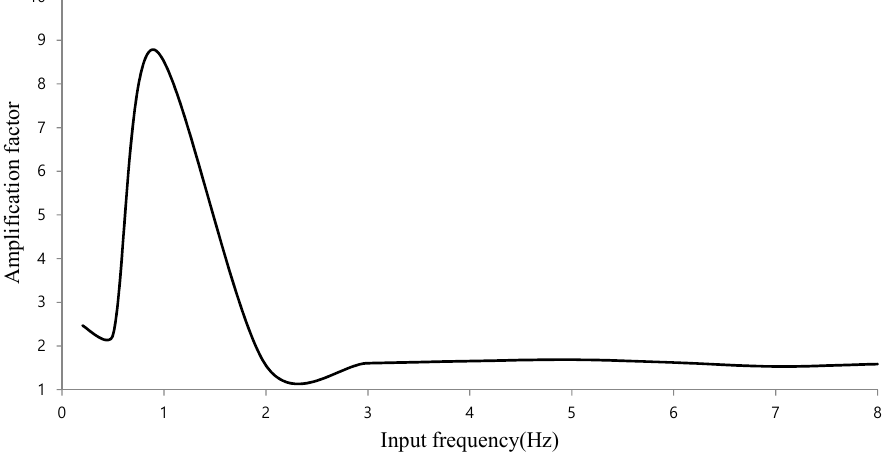
Figure 8. Result of sweep analysis